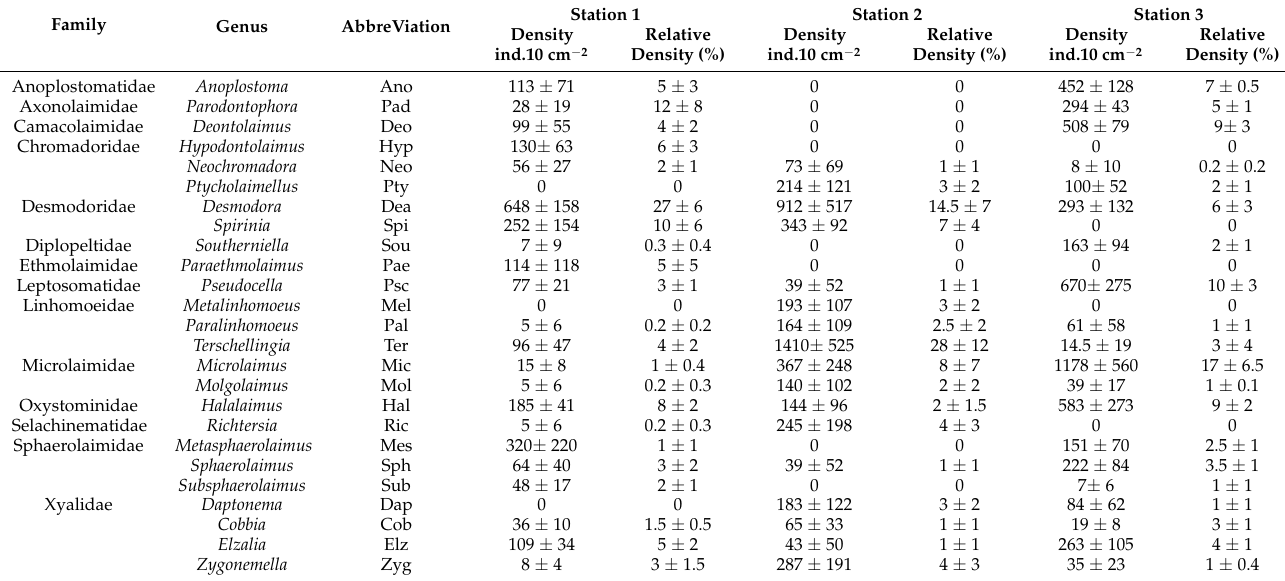
Table 2. Mean total nematode densities (individuals per 10cm 2 ; ± SD) and mean relative nematode densities (%; ± SD) at each station (here reported nematodes with at least 2% density on one station). The nematoda exhaustive list including those with a relative density < 2% is presented in Figure S3 with their appartenance trophic groups.